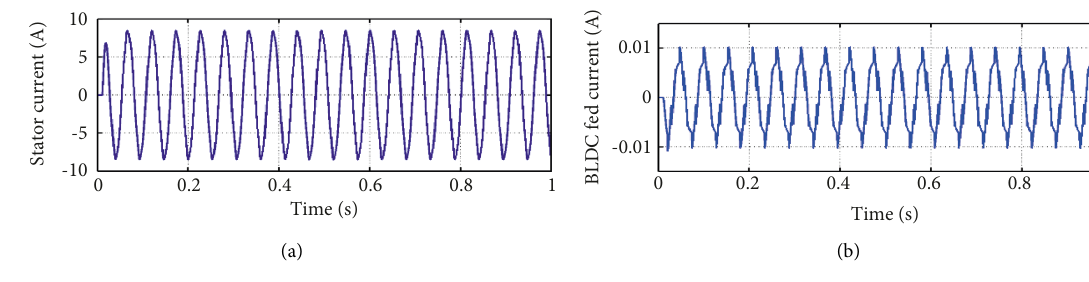
Figure 17: (a, b) Stator currents of BLDC motor. Table 2: Parameters of the BLDCM.